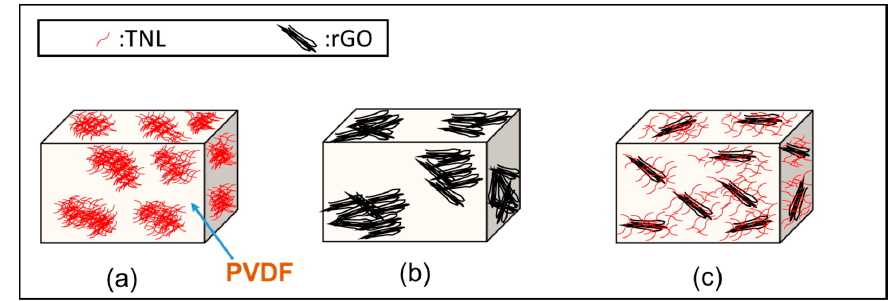
Figure 7. Schematic representation of the dispersion of nanoparticles in: ( a ) PVDF/TNL; ( b ) PVDF/rGO; and ( c ) PVDF/rGO-TNL.